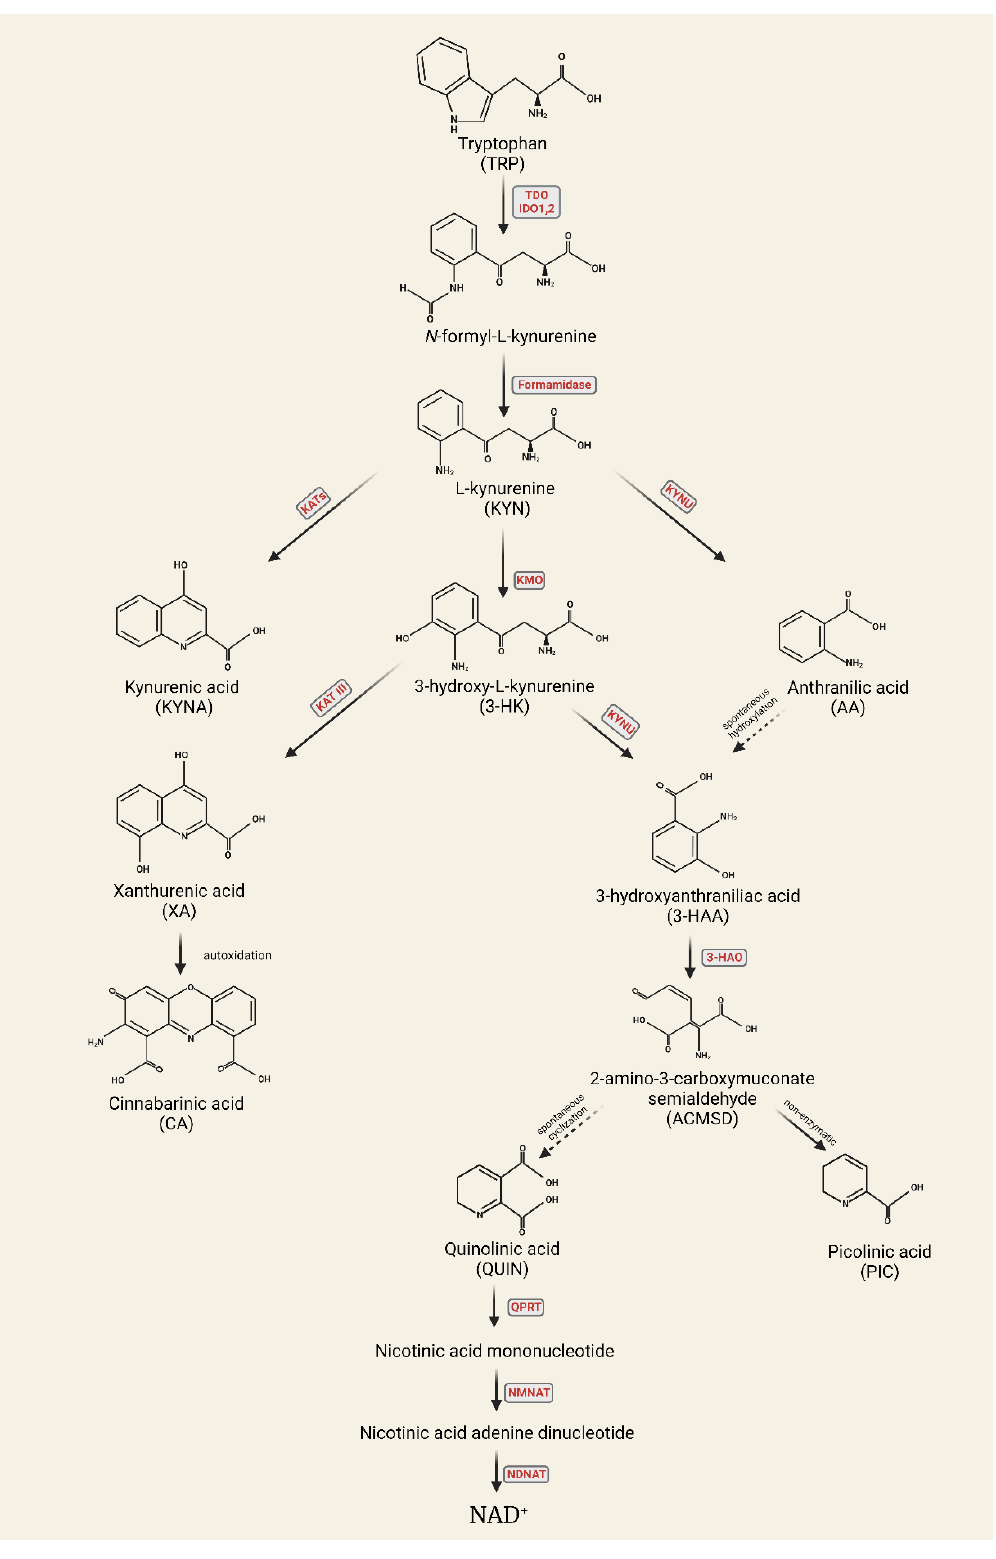
Figure 5. Kynurenine